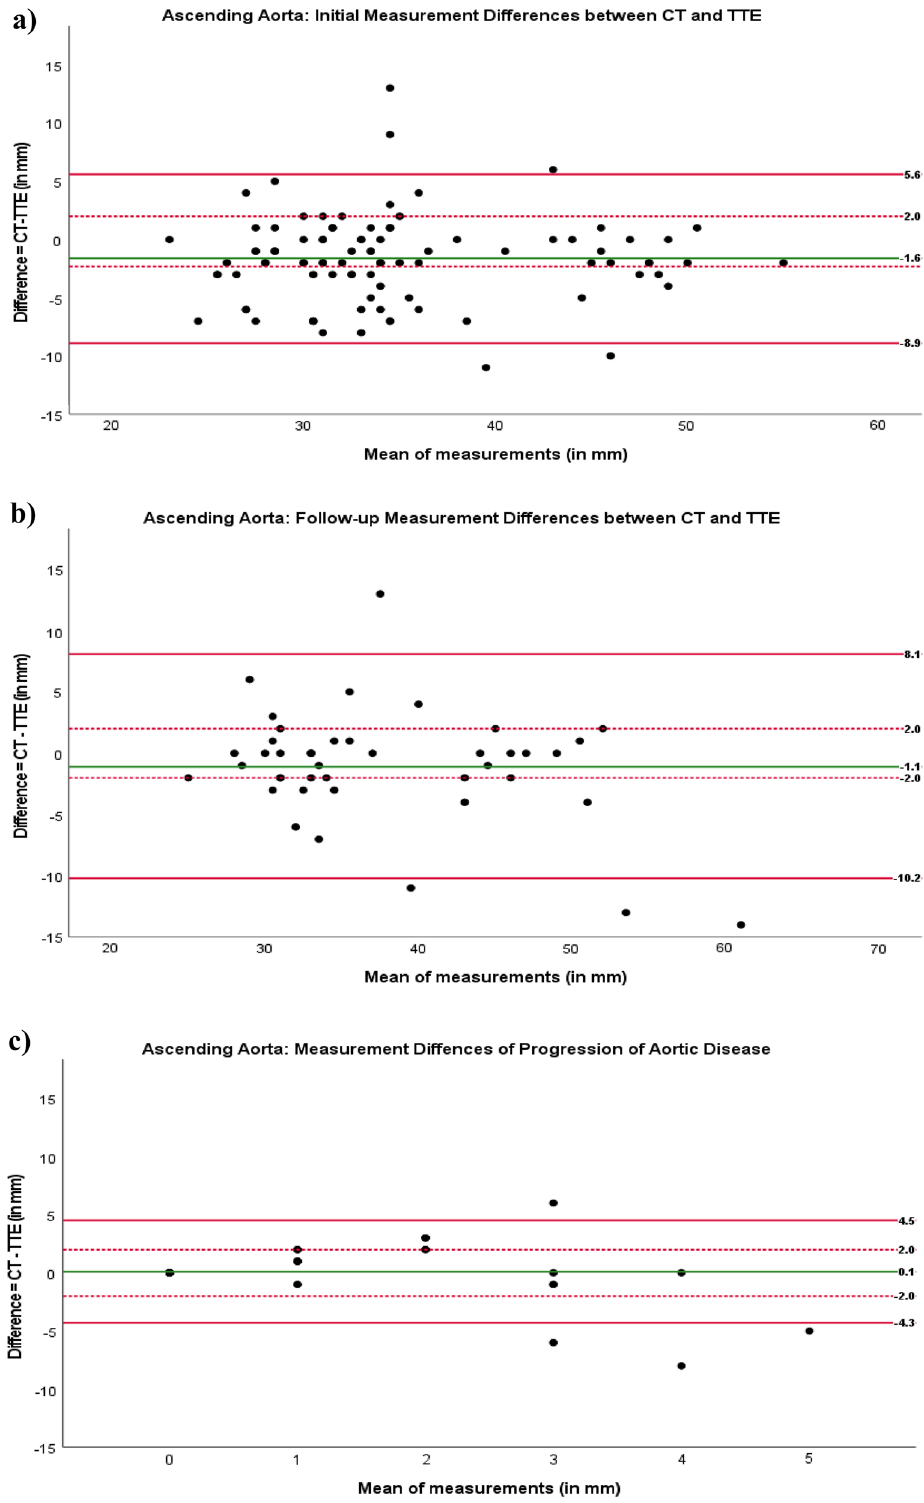
Figure 3. Bland–Altman plots for analysis of measurement differences in ascending aorta diameter in patients with Marfan syndrome or a related disorder for ( a ) initial work-up, ( b ) follow-up, and ( c ) progression of aortic disease. Red lines: upper and lower limits of agreement. Dotted red line: clinically acceptable limit of agreement for difference. Green line: agreement